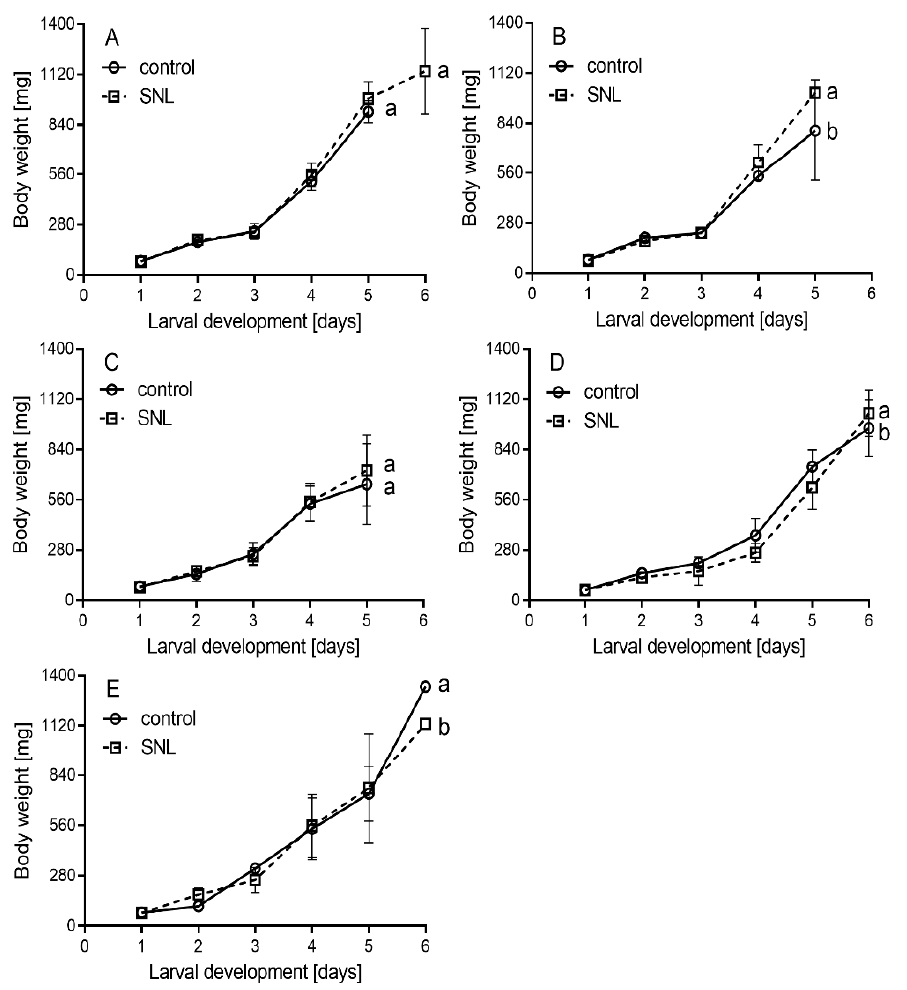
Figure 4. The body weight gain of S. littoralis (mean ± SD) larvae in N ( A ), NRC ( B ), CU ( C ), SE ( D ), and SF ( E ) populations in bioassay 3 with GE potato SNL expressing Cry3Aa and control potato Superior. The same letters denote non-significant differences, while different letters denote statistically significant differences. The values of statistical tests are available in Table S2C. N-population of S. littoralis reared in our laboratory; NRC—population of S. littoralis obtained from National Research Centre, Egypt; CU—population of S. littoralis obtained from Cairo University, Egypt; SE—sensitive population of S. littoralis obtained from Egypt; SF—sensitive population of S. littoralis obtained from France.